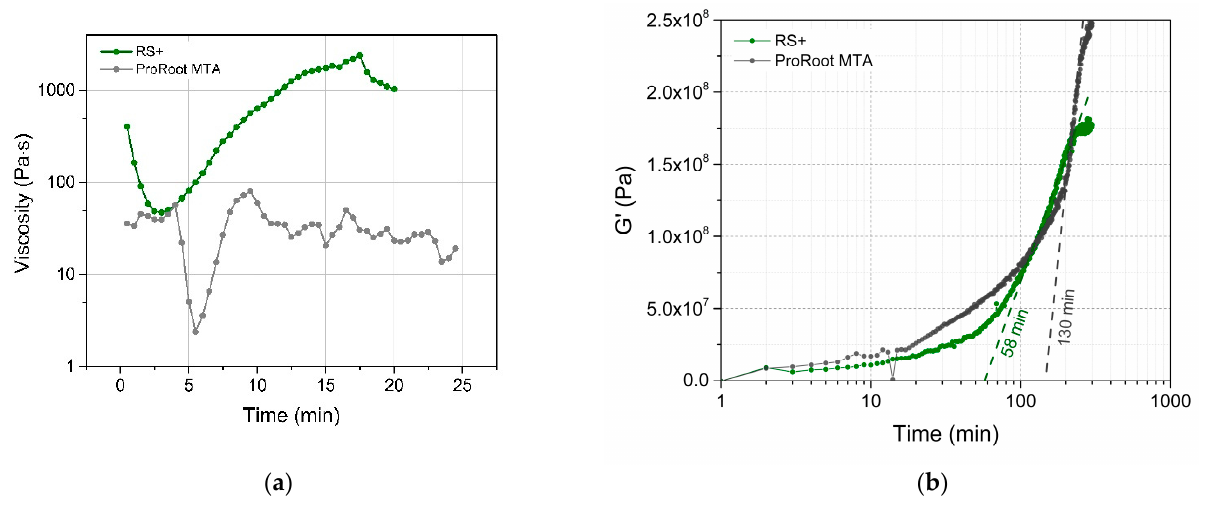
Figure 10. ( a ) Viscosity of RS+ and ProRoot MTA plotted as a function of time at the fixed shear rate; ( b ) storage modulus of RS+ and ProRoot MTA plotted as a function of time.